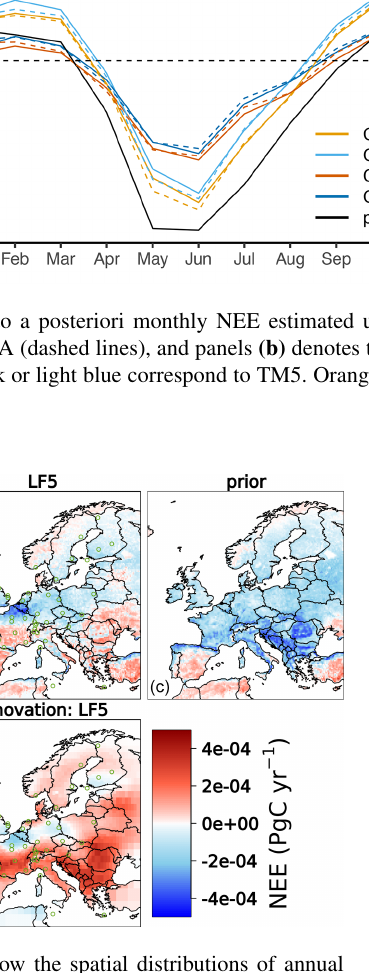
Figure 2. Panels (a) – (c) show the spatial distributions of annual NEE estimated with the base inversions CS3 and LF5, as well as their prior. Panels (d) and (e) depict the innovations of fluxes cal- culated for the inversions CS3 and LF5. Green circles denote the locations of observational sites.